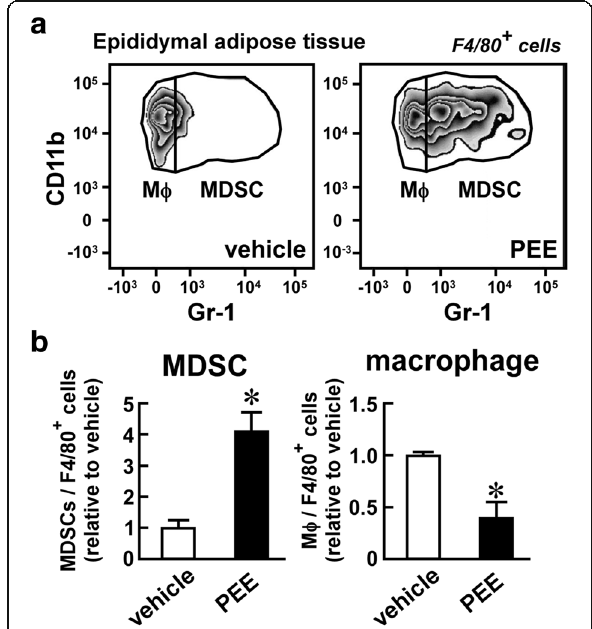
Fig. 3 Effects of PEE on the number of macrophages and MDSCs in the epididymal adipose tissue of lean mice. Normal chow-fed C57BL/6 mice were intraperitoneally injected with PEE (100 mg/kg, twice weekly) or vehicle for one month. a Representative FACS images of four replicates. Only F4/80 + living cells are shown. b Proportion of macrophages and MDSCs in F4/80 + myeloid cells. Data represents means ± SD of four samples. * P <0.05 vs. vehicle-treated mice